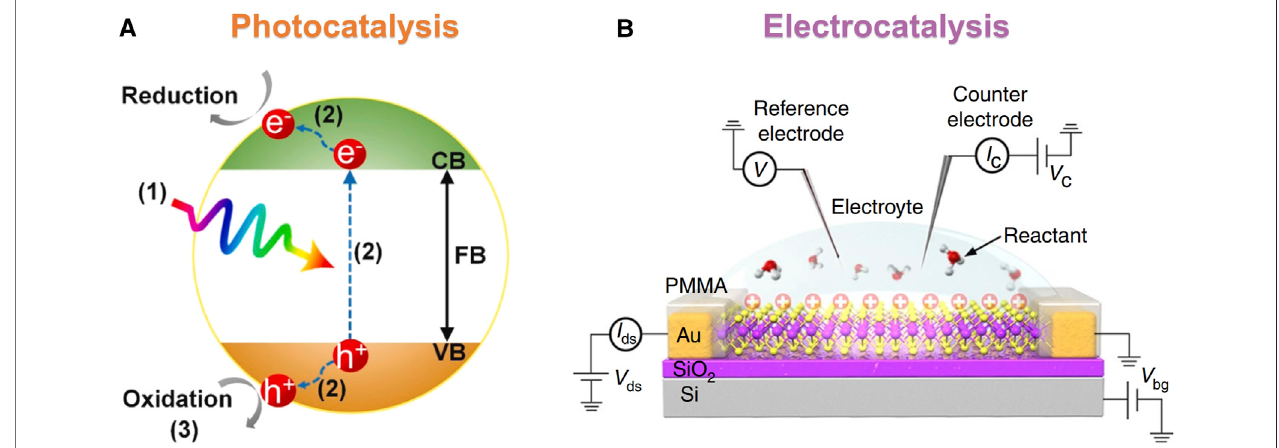
FIGURE1| Schematic diagram oftheprinciples ofphotocatalysis and electrocatalysis. (A) Thetypical photocatalyticprocess goes through threesteps (Zhu et al., 2021). (B) Schematicdiagramofelectrocatalyticmeasurement(Heetal.,2019).ReproducedfromZhuetal.(2021)withthepermissionoftheElsevier.Reproducedfrom He et al. (2019) with the permission of Springer